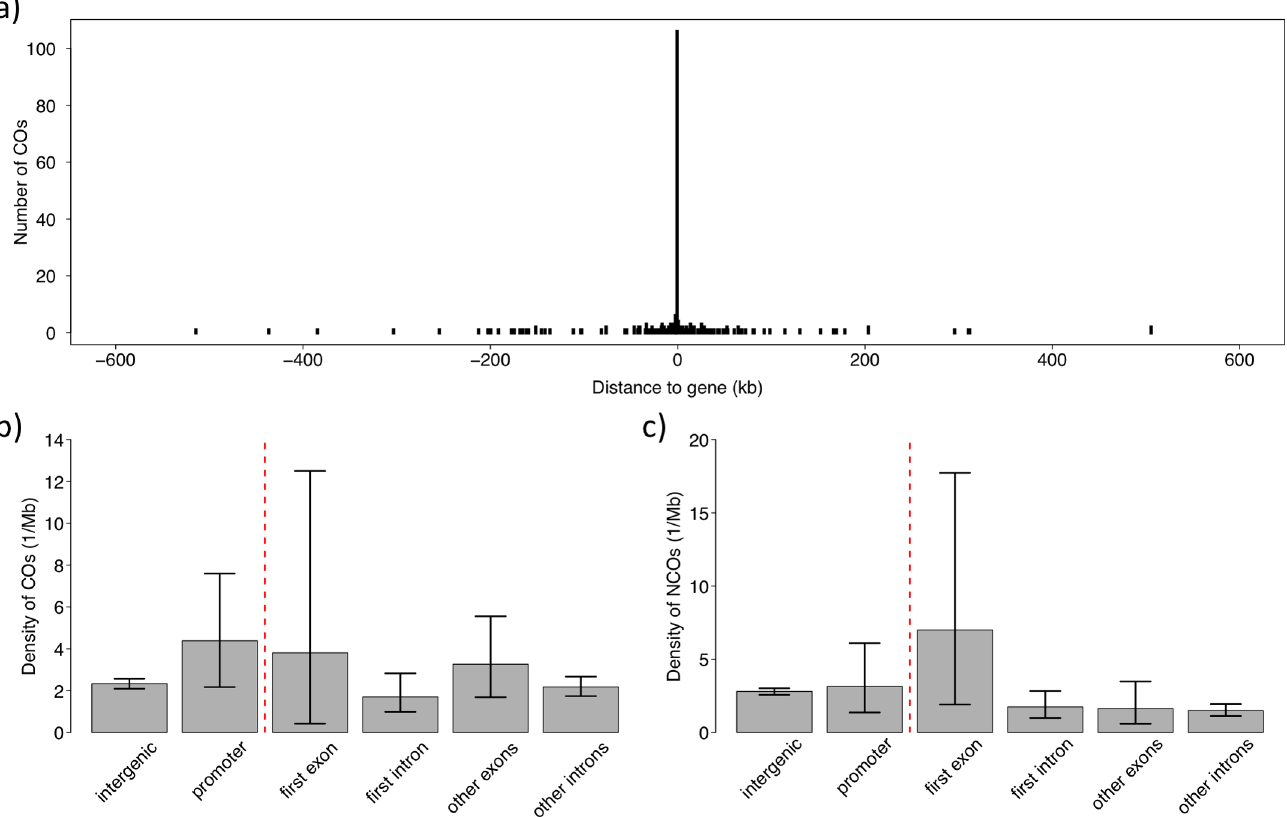
Fig 5. The association between recombination and genes. ( a ) Distribution of recombination events in relation to distance to the closest gene. The large bar at position 0 represents the number of events overlapping with genes. ( b ) Density of CO events in different sequence categories of genes, and in intergenic DNA. c ) Density of NCO events in different sequence categories of genes, and in intergenic